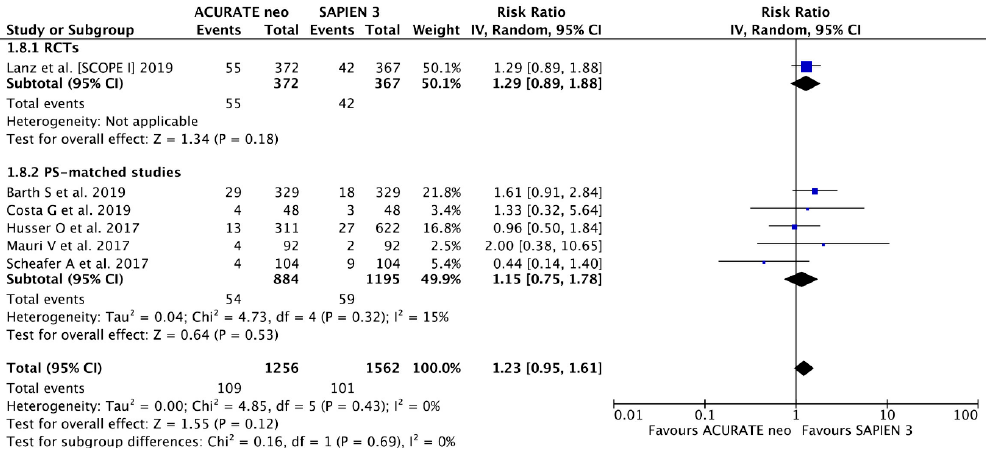
Figure A11. Clinical outcomes. Individual and summary risk ratios with corresponding 95% confidence intervals for the comparison of ACURATE neo and SAPIEN 3 in the analysis serious bleeding events.